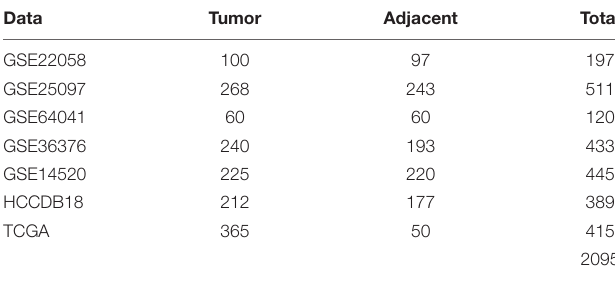
TABLE 1 | Clinical statistics of the sample.